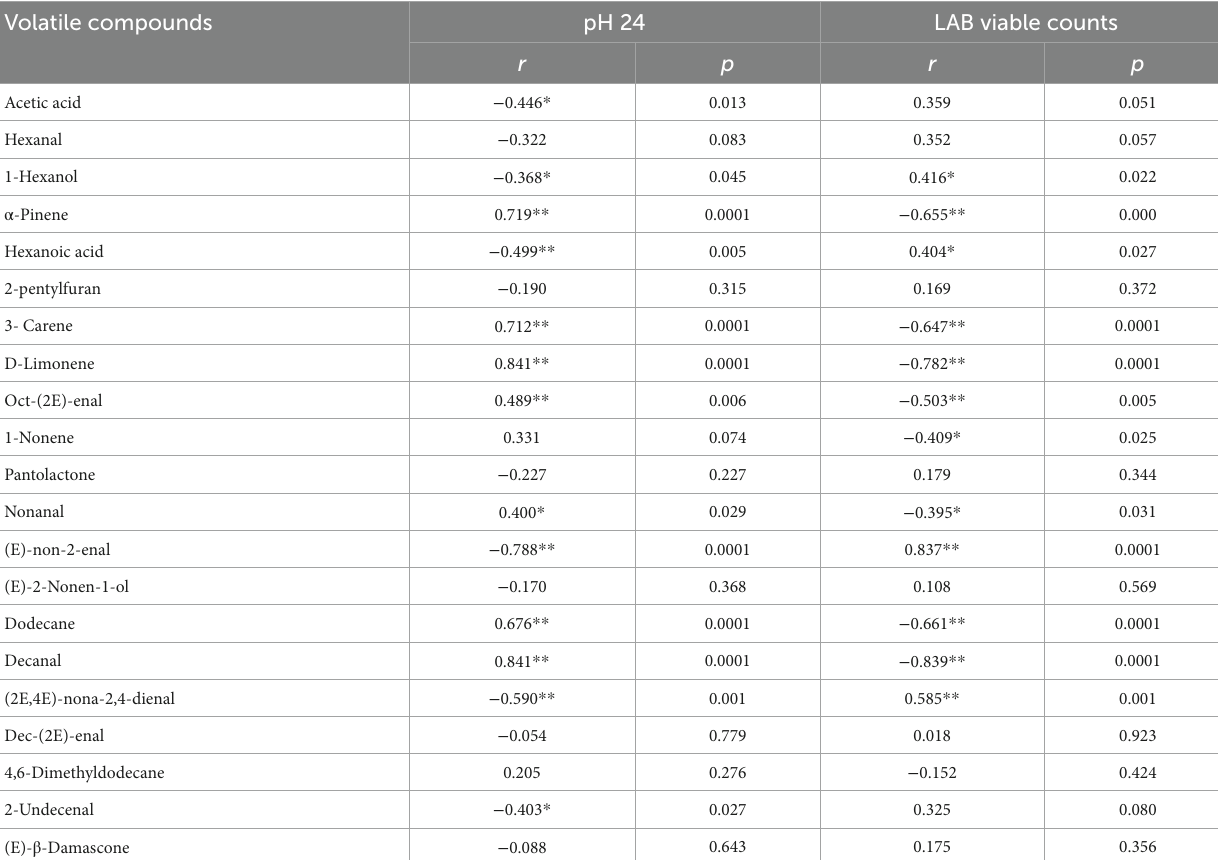
TABLE 5 Pearson correlations between pH and lactic acid bacteria (LAB) viable counts with volatile compound (VC) content in lentil samples. Volatile